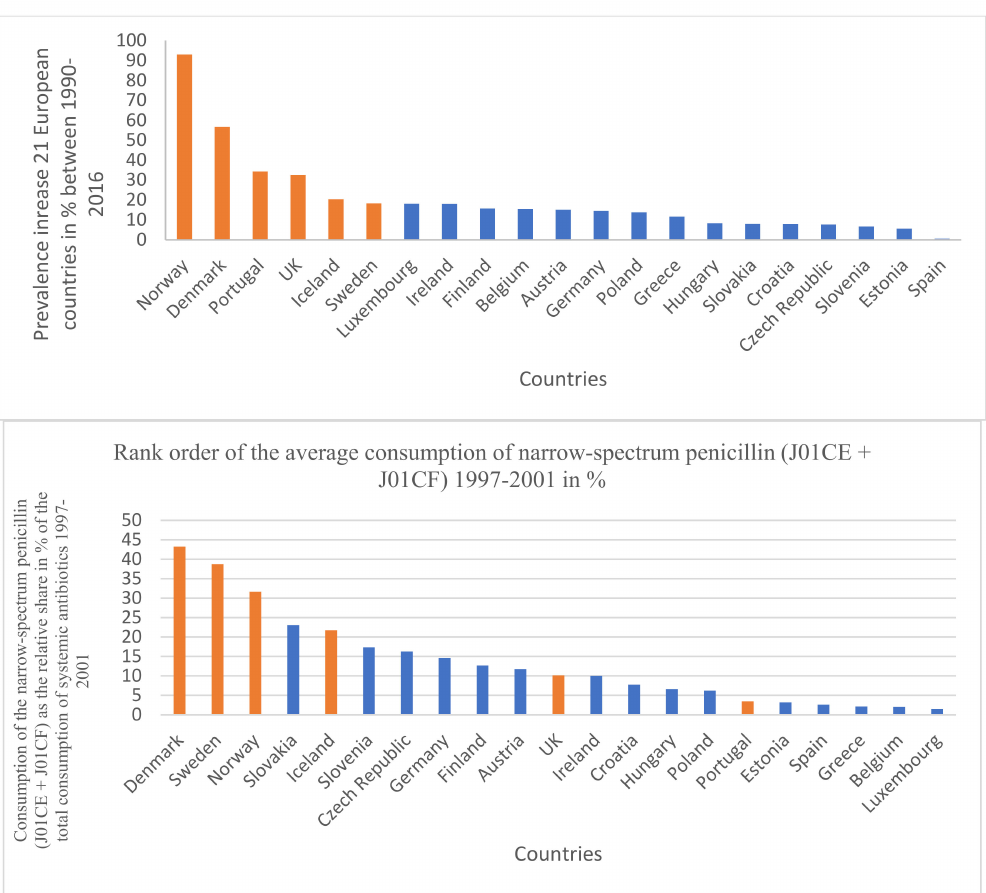
Figure 2. Rank order of prevalence increase of PD in 21 European countries (%) for the time period 1997–2011 and the rank order of the consumption of narrow-spectrum penicillin (J01CE + J01CF). Identical countries are marked with orange filling color. Out of six countries with the highest increase of PD prevalence, four countries are identical with the penicillin-consumption rank order